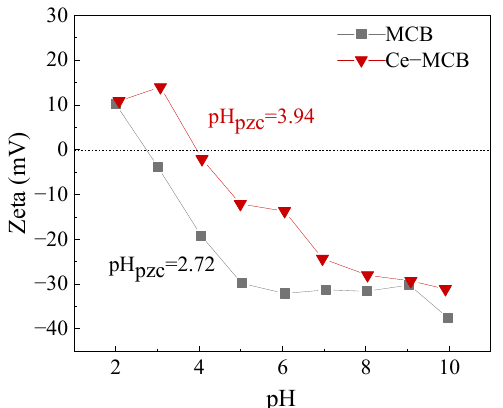
Figure 4. Zeta potential of MCB and Ce-MCB at different solution pH.